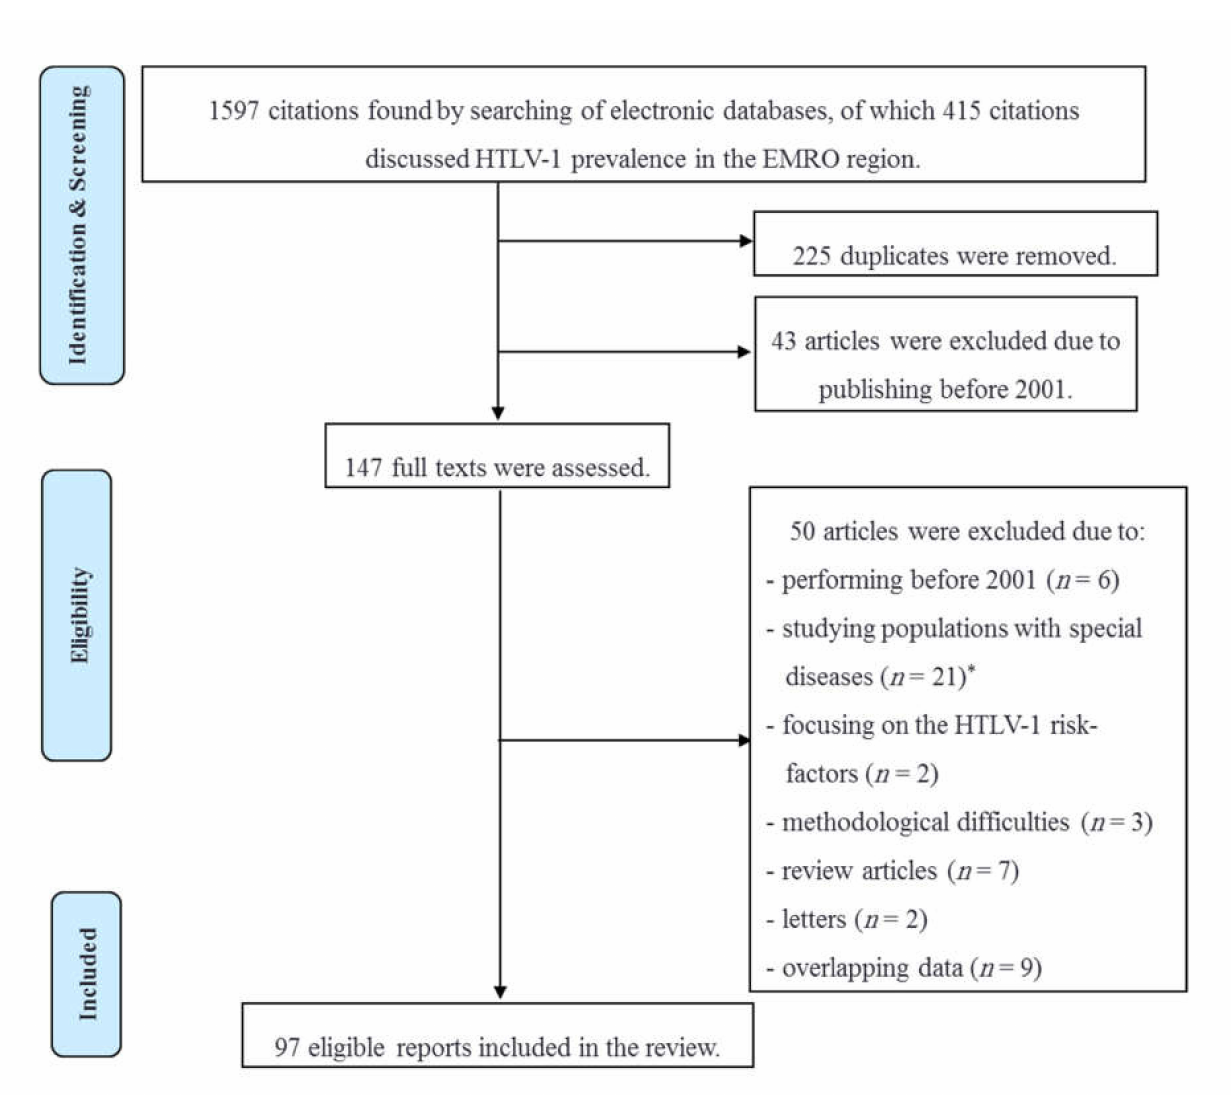
Figure 1. Study selection for the review of HTLV-1 infection epidemiology in the countries of the Eastern Mediterranean Regional Office of the World Health Organization. * Patients with dermato- logical, hematological, rheumatological, or autoimmune disorders; carcinomas; infectious diseases other then HIV/AIDS; chronic diseases such as cardiovascular disorders and diabetes Melitus,